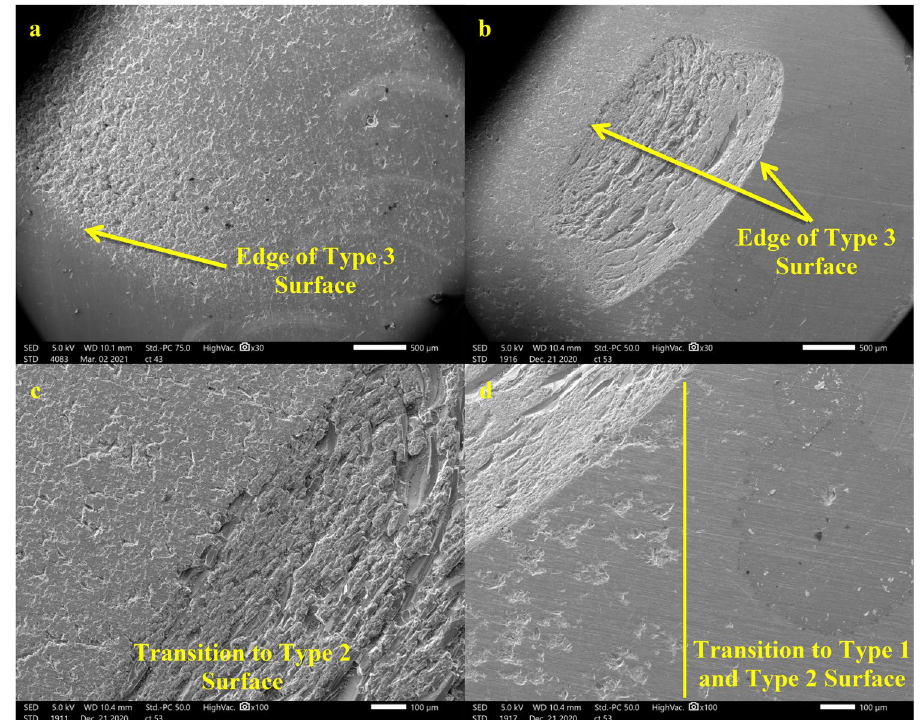
Figure 3. Edge of Type 3 erosion at 30 × ( a , b ) and 100 × ( c , d ) magnification. c shows a transition to a Type 2 surface while d shows a transition to both Type 1 and Type 2 surfaces with a yellow line added to show the separation between the regions. The micrograph in a was from a 20 W cm −2 , 1 h experiment while the micrographs for b-d are from a 20 W cm −2 , 7.5 h